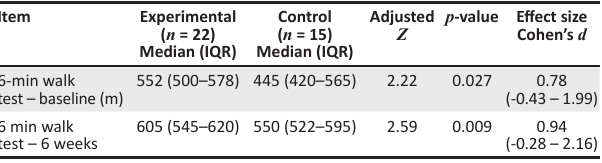
TABLE 7: Between-group comparisons for the 6-min walk test. Item